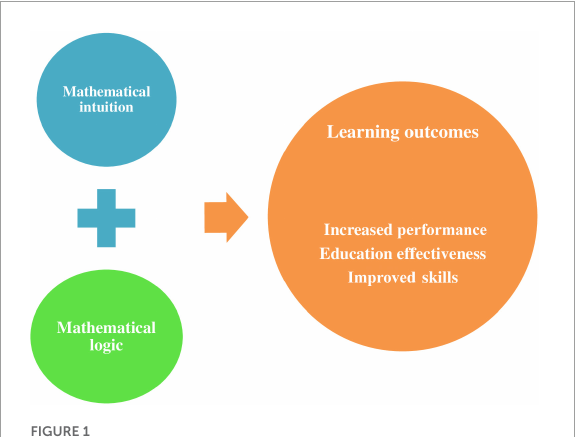
FIGURE1 The relationship between students’ mathematical intuition, logic, and learning